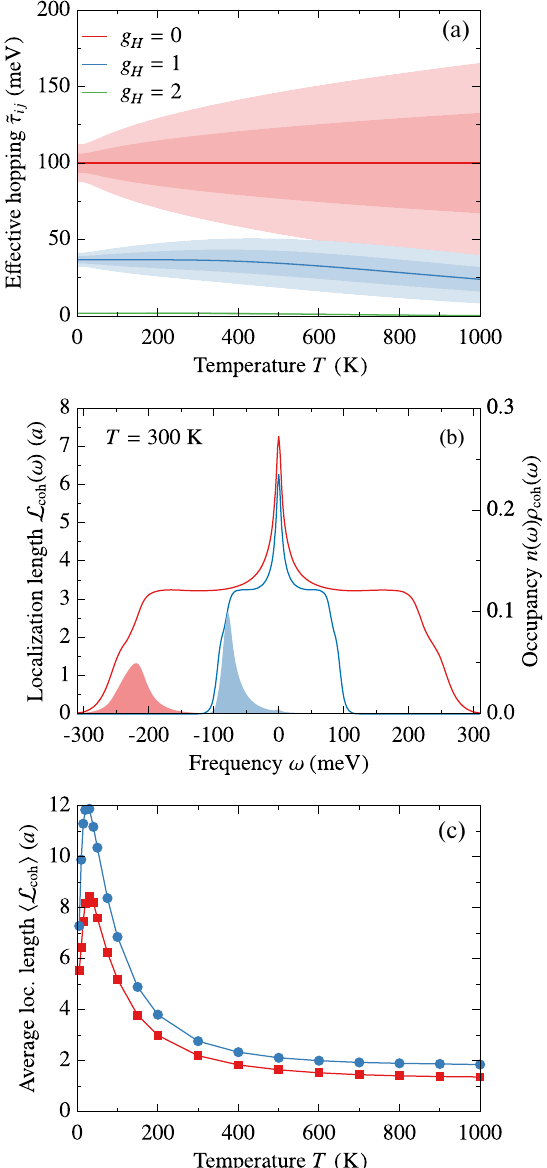
FIG. 4. (a) Band-narrowed nearest-neighbor hopping ˜ τ (solid lines) for which the bare value is τ ¼ 100 meV. Shaded regions represent 1 standard deviation in the distribution of values that ˜ τ can 1 , darker take under Peierls disorder with moderate coupling ( g P ¼ 2 , lighter shading). (b) Energy- shading) and strong coupling ( g P ¼ dependent localization length (solid lines) for zero Holstein 0 , red) and moderate Holstein coupling ( g 1 , coupling ( g H ¼ H ¼ blue) and thermally occupied density of states (shaded regions). 2 . Results are shown for T ¼ 300 K and Peierls coupling g P ¼ 2 . All other parameters are the same as in Fig. coupling g P ¼